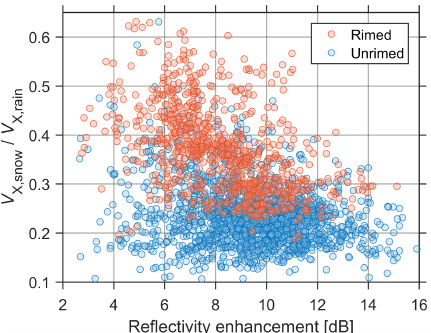
Figure 4. Scatter plot of V X , snow /V X , rain versus reflectivity en- hancement in the ML. The reflectivity enhancement is defined as the difference between the reflectivity peak in the ML and the re- flectivity in rain just below the